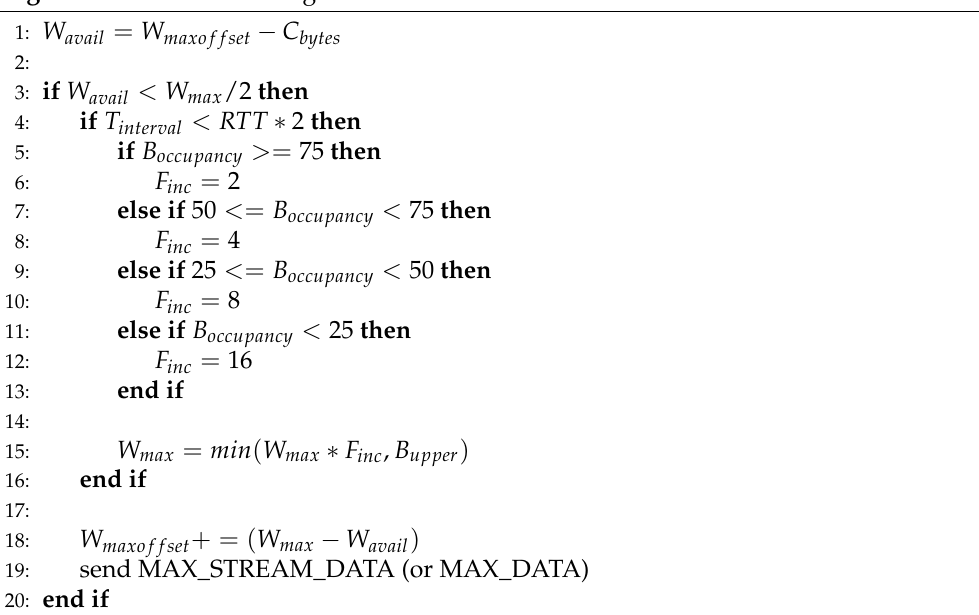
Algorithm 1 Fast